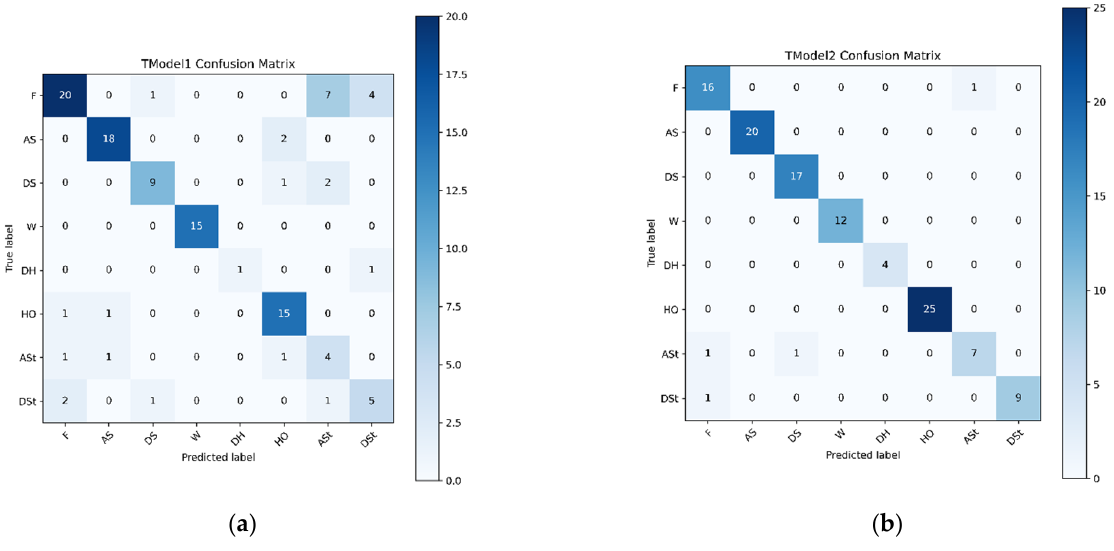
Figure 24. Deep Learning Confusion Matrix on the Test Dataset: ( a ) TModel1 and ( b ) TModel2. For TModel2, the highest number of true positives was obtained for the High Obstacle (25) and Ascending Stairs (20) classes, followed by Descending Stairs (17), Wall (12), Descending Step (9), Ascending Step (7), and Deep Hole (4). The total number of wrong predictions for the classes are Floor (1), Ascending Step (2), and Descending Step (1). Note